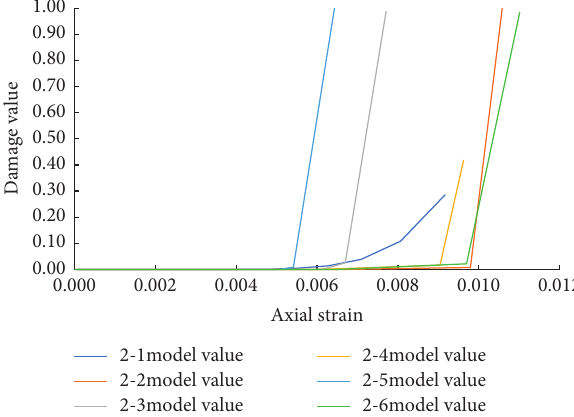
Figure 9: Theoretical curve of filled cracked rocks with cement